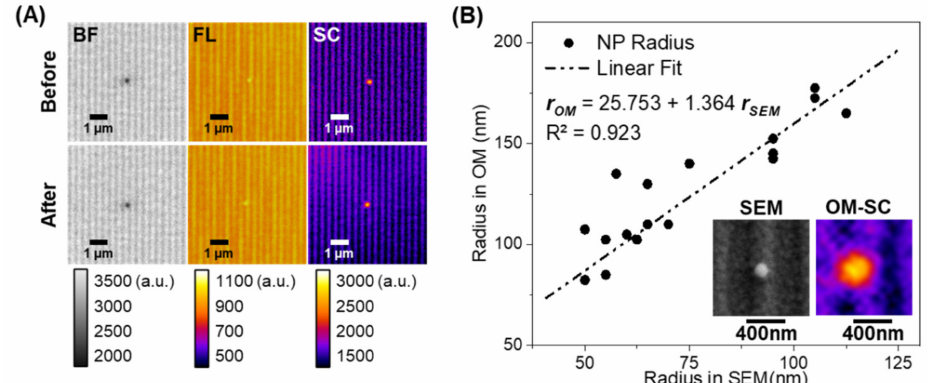
Figure 3. ( A ) Single Al NP imaged before and after laser-induced heating using brightfield (BF), fluorescence (FL), and polarization-based scattering (SC) modes. (Note: images are false color with intensity indicated by the intensity bars. ( B ) SEM and polarization-based scattering optical microscope images are used to calculate the ratio to measure the actual dimension of the nanoparticle. (Inset) SEM and optical microscope scattering (OM-SC) images of the same Al NP at the same relative